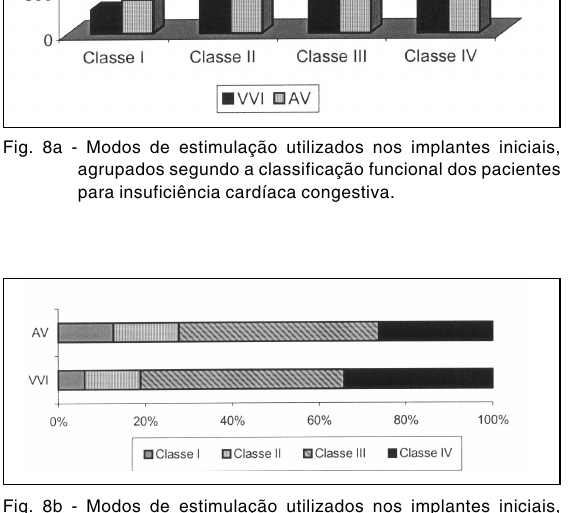
Fig. 9b - Modos de estimulação utilizados nos implantes iniciais, agrupados segundo o achado eletrocardiográfico dos